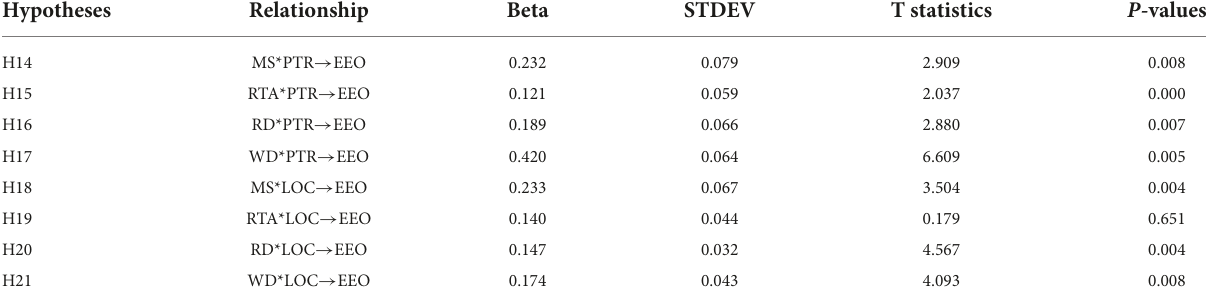
TABLE 7 Structural model assessment (moderation effect).